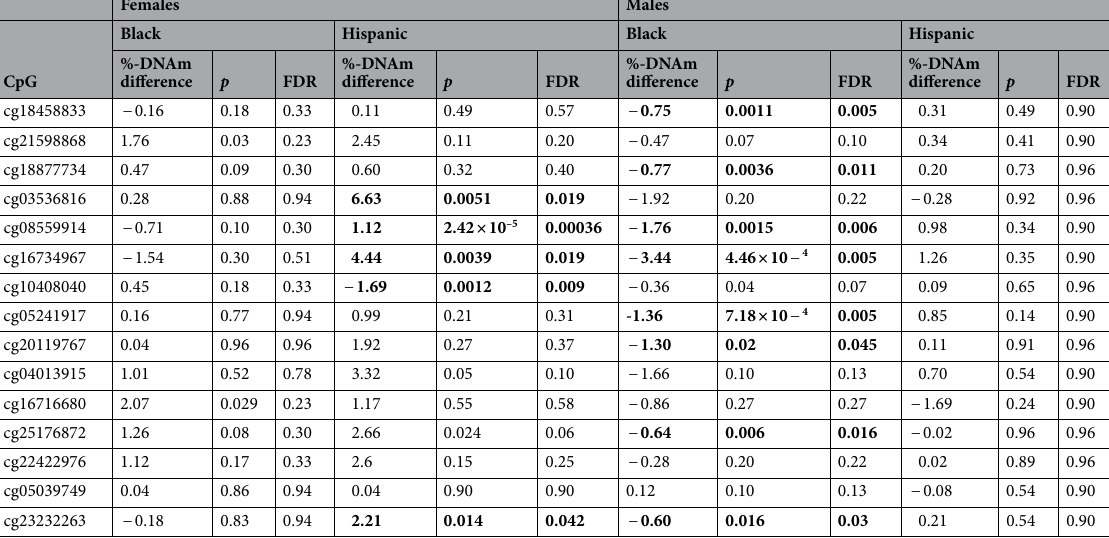
Table 2. Differences in %-DNAm in Black and Hispanic relative to white participants adjusted for age and stratified by sex. Bold values indicate FDR <0.05.